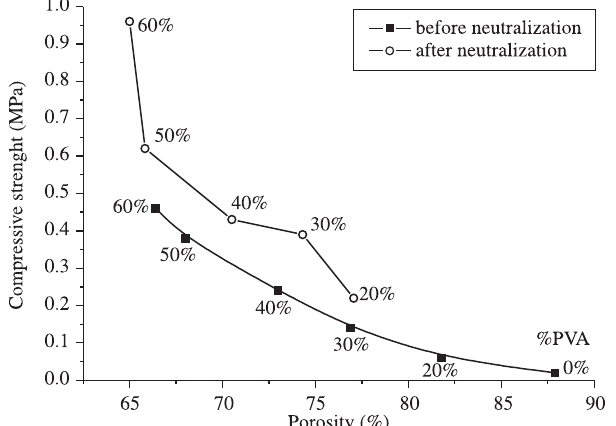
Figure 8. Compressive strength as a function of porosity and polymer content in